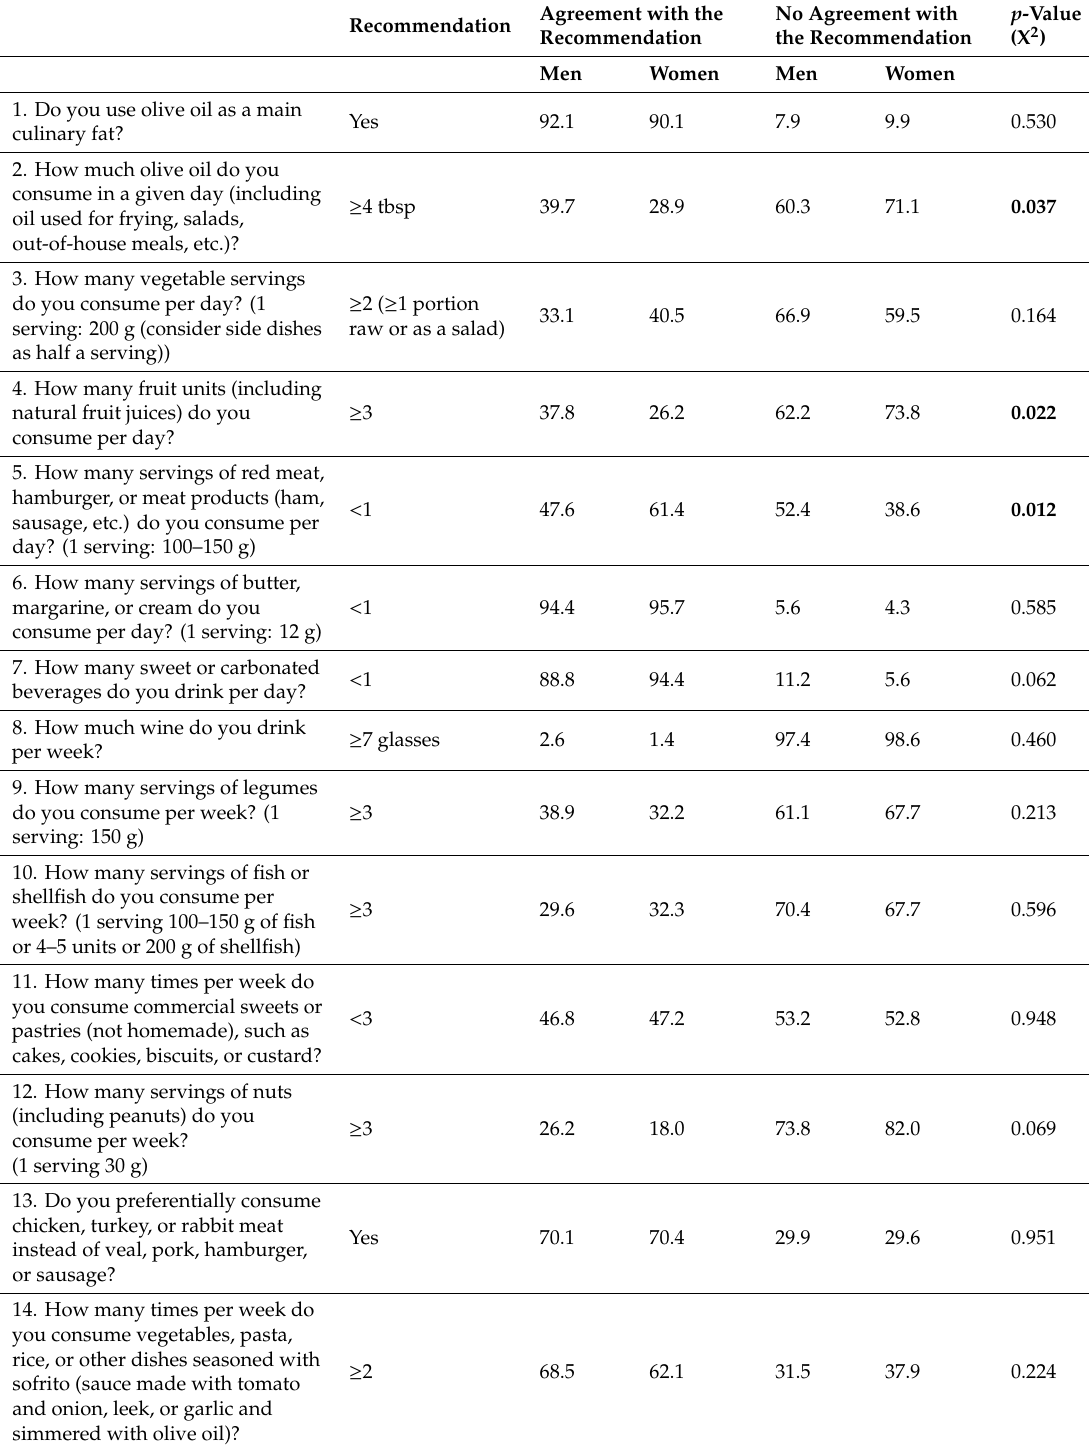
Table 2. Agreement with the recommendations based on each item of the Mediterranean Diet Adherence Screener (MEDAS-14 item score), by